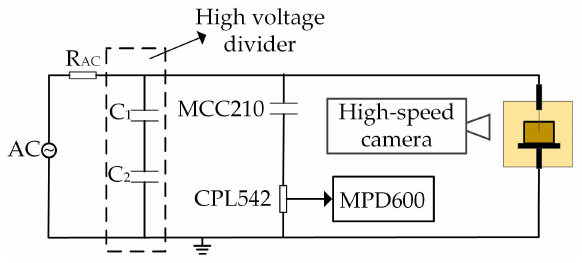
Figure 2. Diagram of the experimental setup.